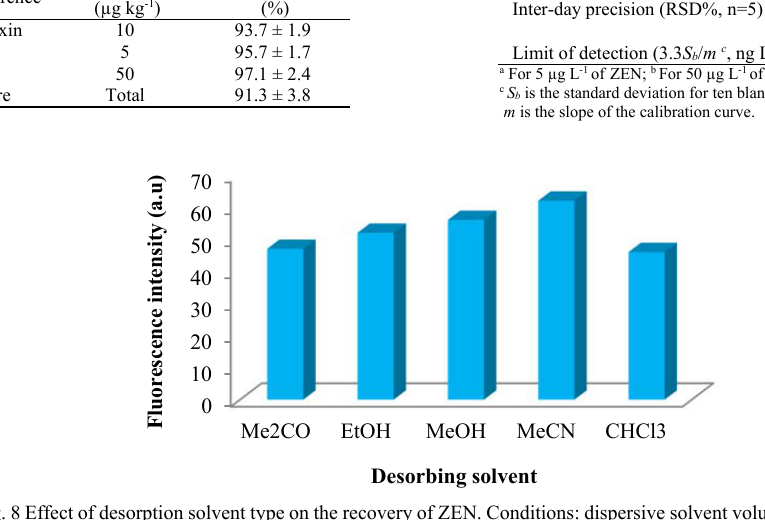
Table 1 Effect of mycotoxins interferences on the extraction efficiency of 5 µg kg -1 of ZEN.